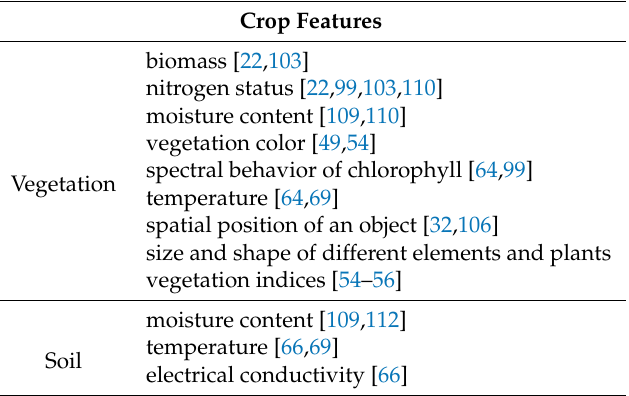
Table 1. Crop features that can be monitored with